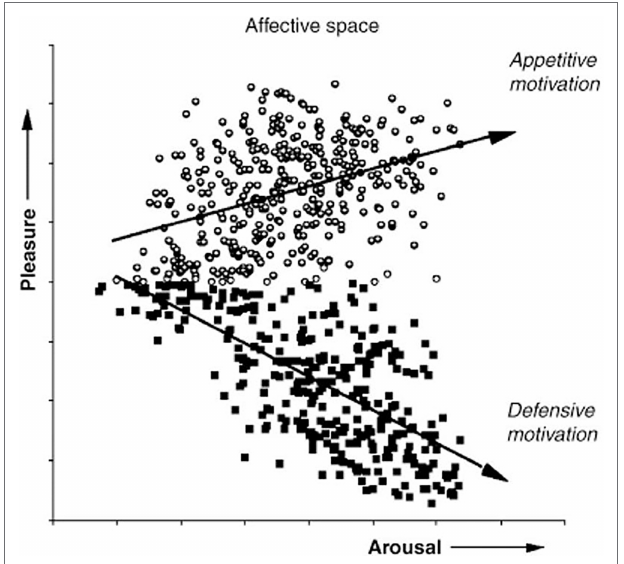
FIGURE 10 | Appetitive vs defensive orienting motivation and emotion . The ratings of pleasure and arousal are consistent with the hypothesis that evaluation of evoked response potential in the frontal cortex reflects the level of subcortical activation in conserved autonomic appetitive or defensive motivational systems. (From Bradley, 2009, permission John Wiley & Sons,